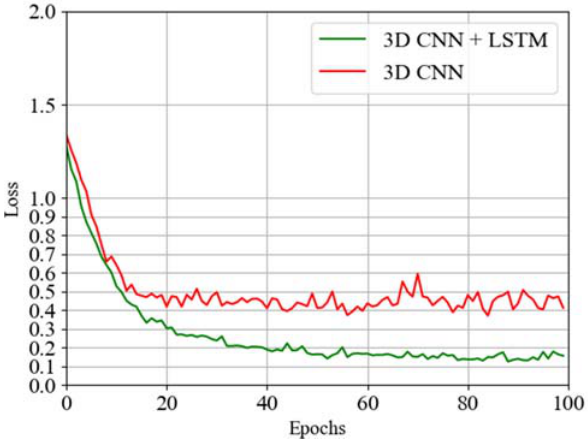
Figure 11. Two loss curves of using only point cloud data as input. Table 2. Accuracy and Loss of The Two Networks Using Point Cloud as Input.